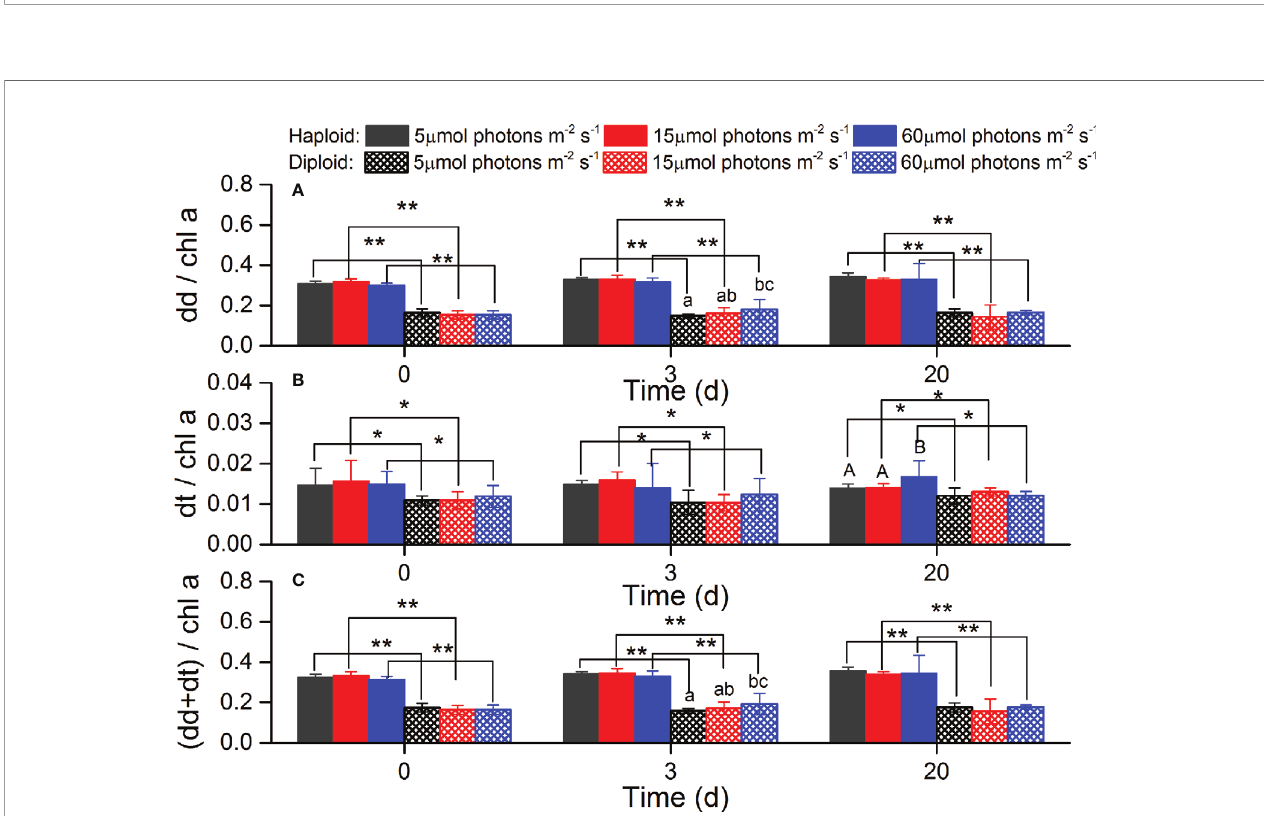
FIGURE 7 | Average contents of diadinoxanthin (dd, (A) ), diatoxanthin (dt, (B) ) and sum of dd and dt (C) for haploid and diploid solitary cells of P. globosa under different light intensities at day 0, day 3 and day 20. Data are normalized to the Chl a content. * and ** indicate signi fi cant differences (p < 0.05 and p < 0.01) between haploid and diploid solitary cells on the same day. Different uppercase and lowercase letters indicate signi fi cant differences among the three light intensities for haploid and diploid solitary cells, respectively.